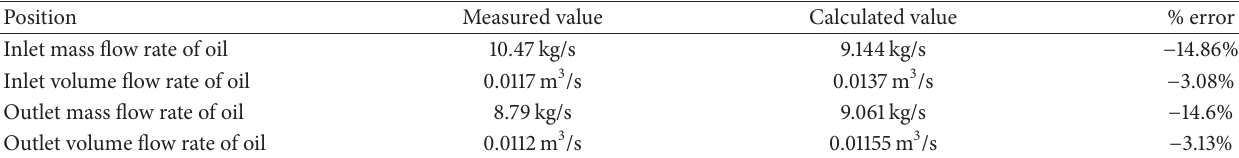
Table 3: Field values and calculated mass and volume flow rates of